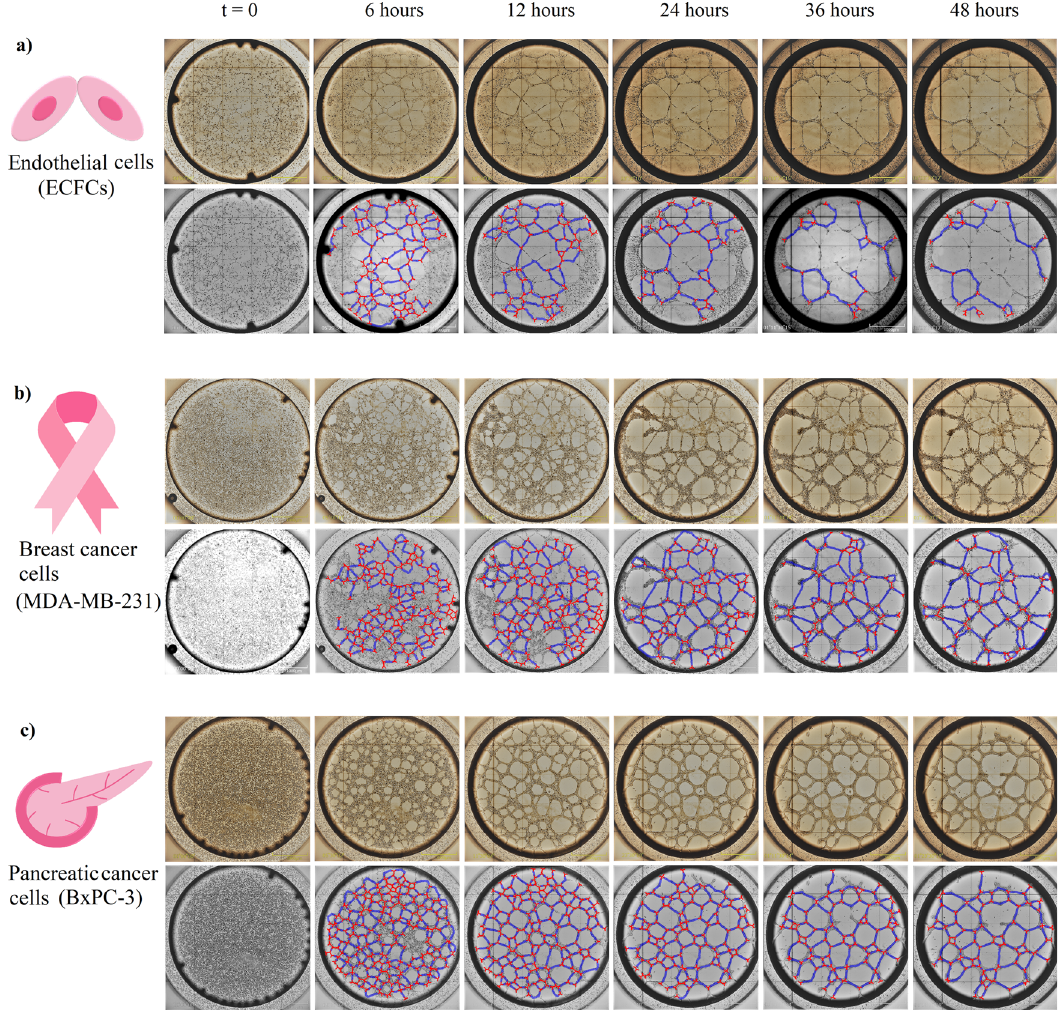
Fig. 1 Identifying edges and vertices from in vitro assays showing formation of angiogenic and VM networks. a The top panel shows how ECs form an angiogenic network, and how this network evolves over time. In the lower panel, we demonstrate the results from our image processing software that extracted the vertices (red) and edges (blue) from the EC network. b Breast cancer cells form a network with short edges in the fi rst 6 h. The length of edges increases and the number of nodes decreases over time. c The formation of the network is demonstrated for pancreatic cancer cells. The arrangements of edges and vertices, and also the edge sizes are more evenly spread than in breast